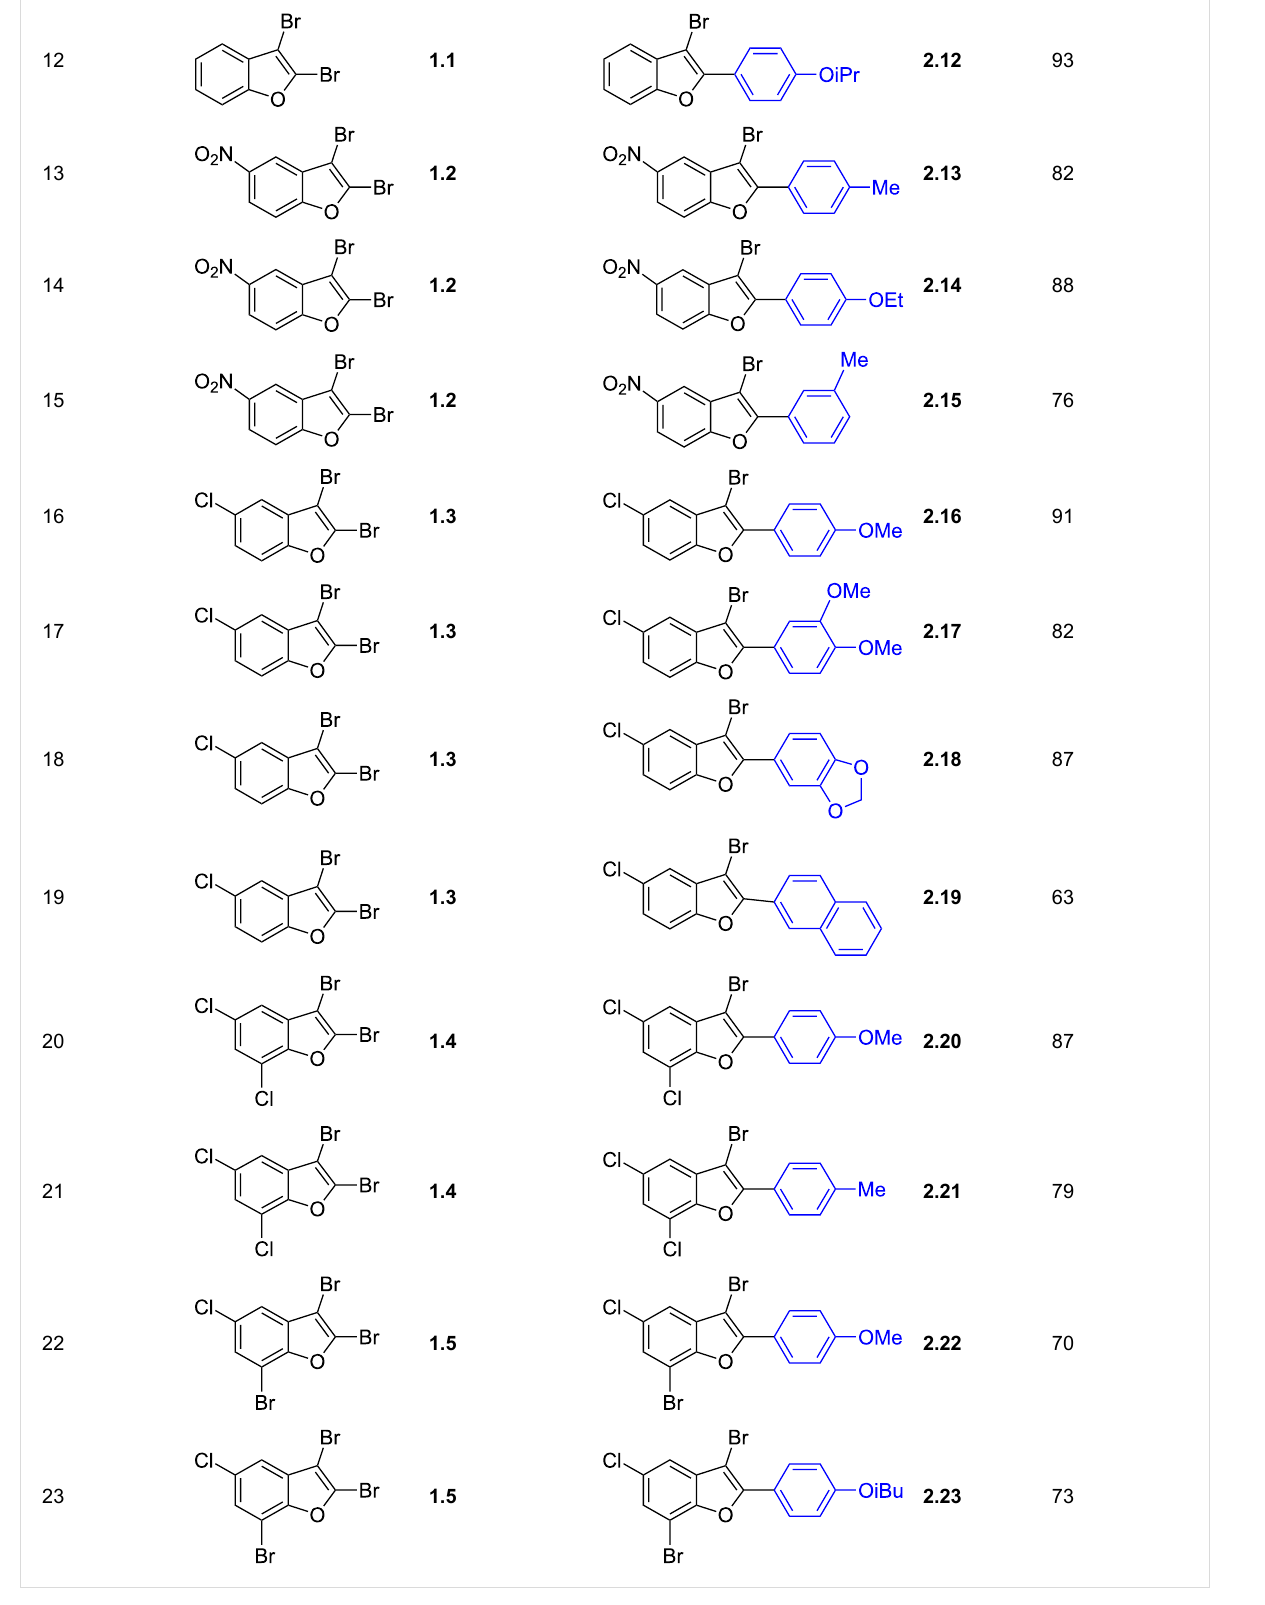
Table 2: Cross-couplings of 2,3-dibromobenzofurans with BiAr 3 reagents. a (continued)